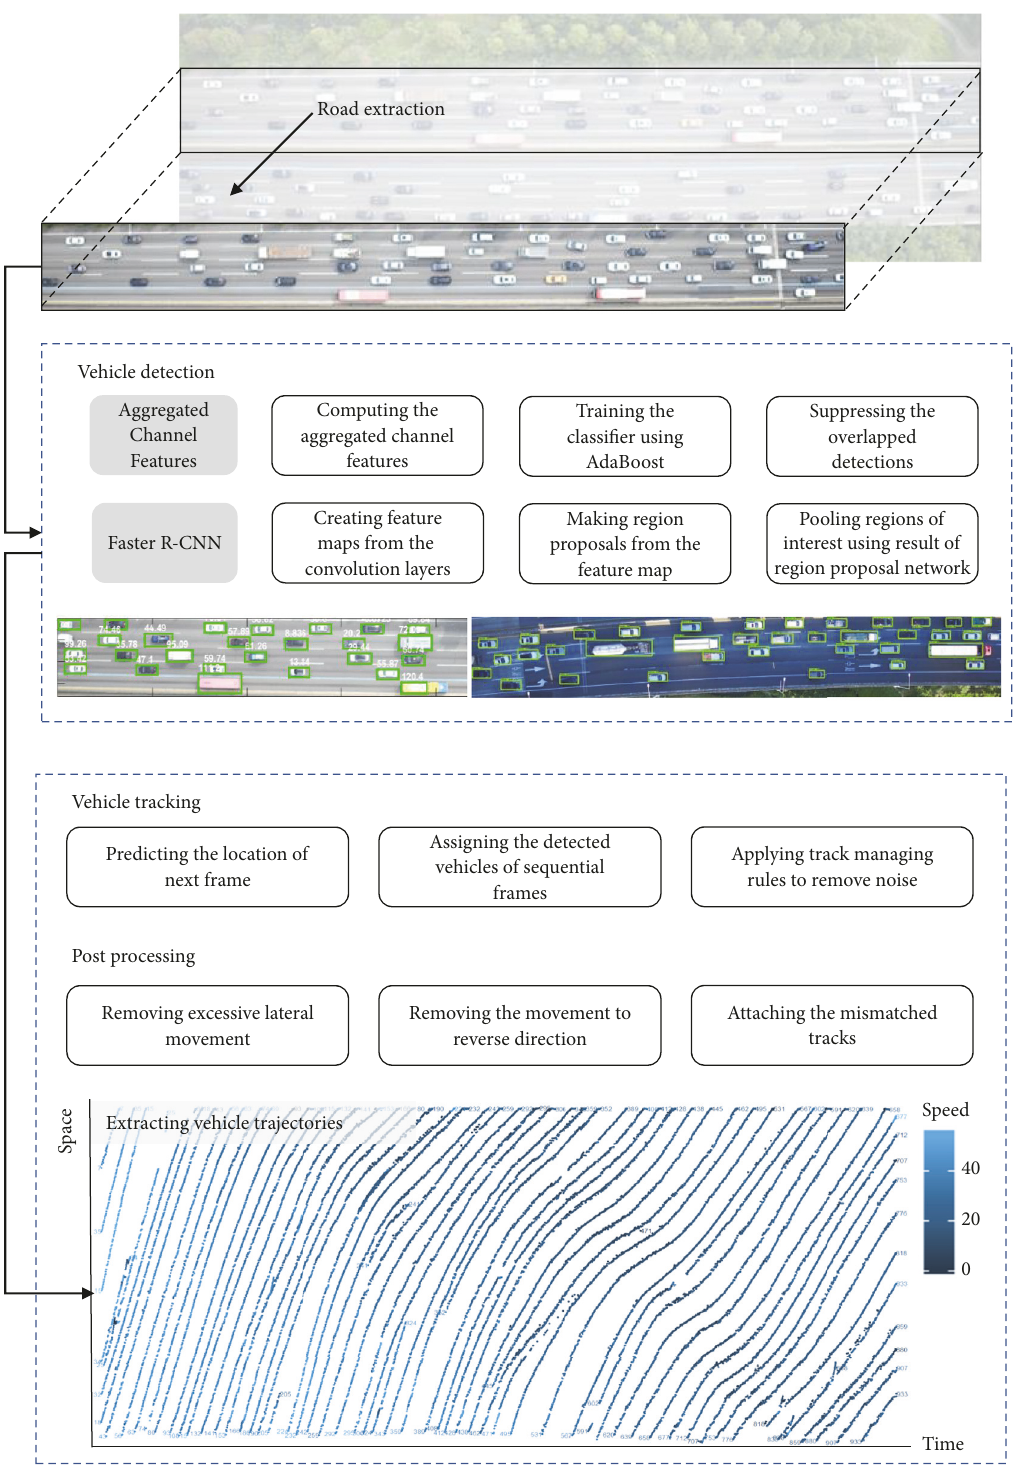
Figure 1: Flowchart of four sequential processes in the proposed framework for extracting vehicle trajectories, i.e., road extraction, vehicle detection, vehicle tracking, and